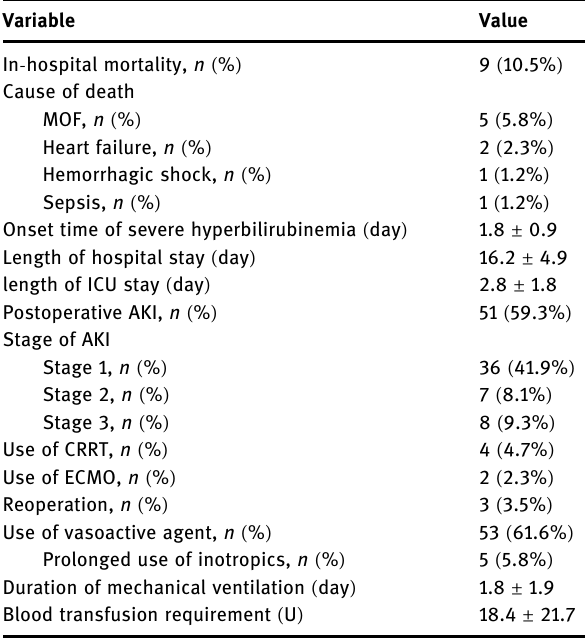
Table 2: Postoperative outcomes of patients